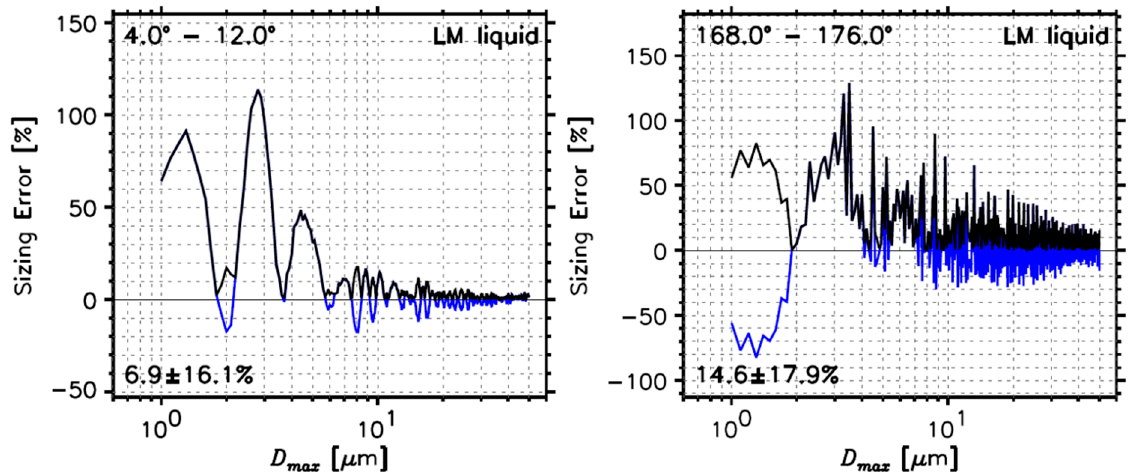
Figure 7. The same as Figure 6, but for a best-fit comparison.